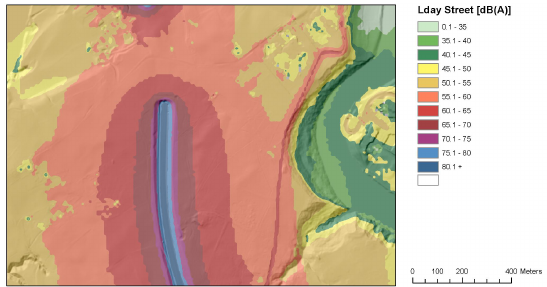
Fig. 4. Sound propagation and topography in sonBASE 2006 based on the terrain model DHM25 of swisstopo, calculated for a height of 4 m above terrain.